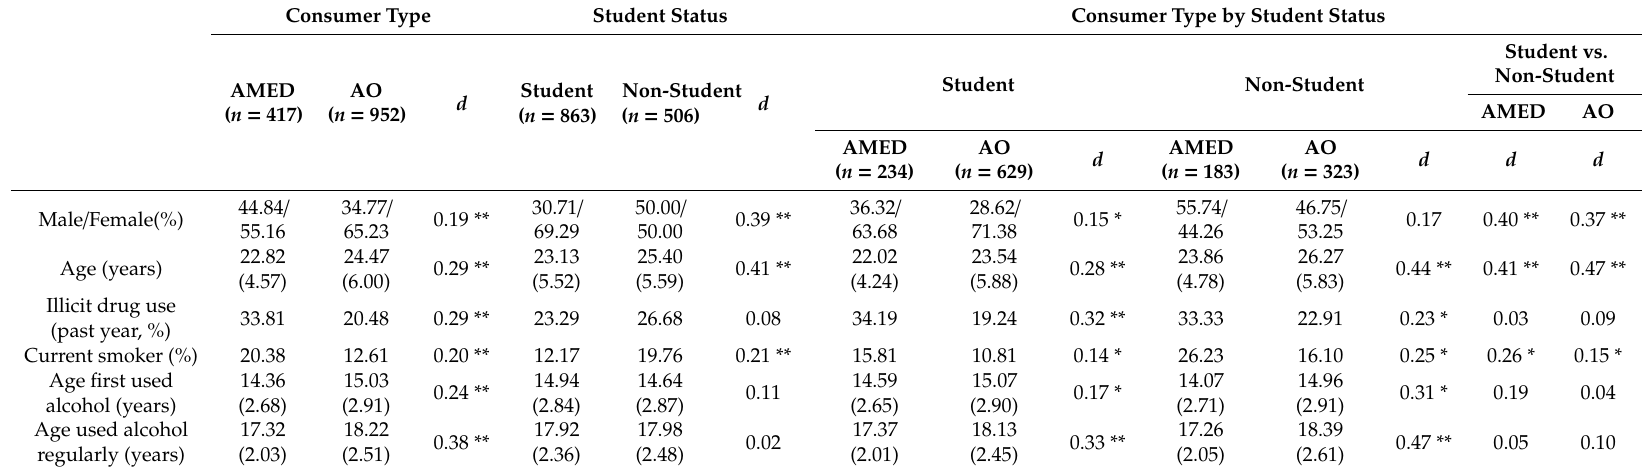
Table 2. Sample characteristics by student status and AMED / AO use. Except for %, numbers are means (with SD in